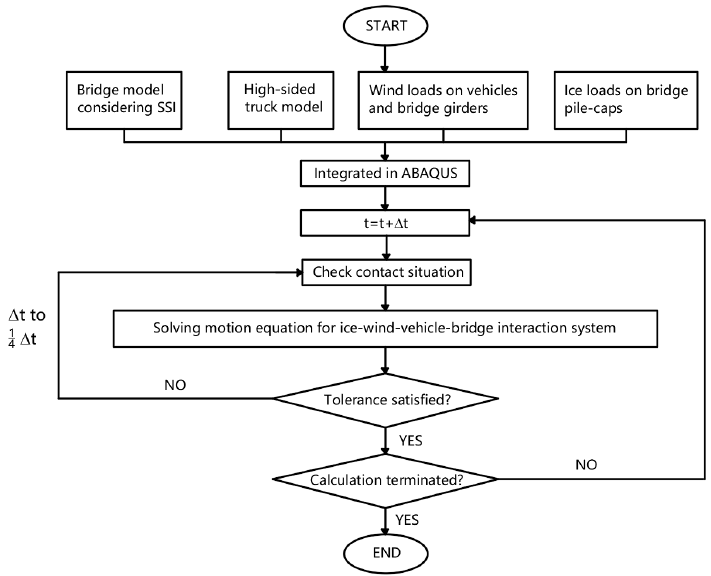
Figure 9. Flow chart of time integration for ice–wind–vehicle–bridge interaction system.